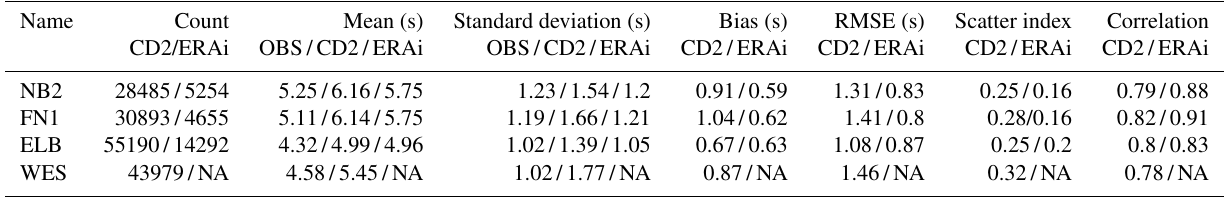
Table 4. Error metrics for the MWP at four locations derived from in situ observations (OBS), coastDat2 hindcast (CD2) and ERA-Interim (ERAi) data for 1h (coastDat2) and 6h (ERA-Interim) data, respectively.